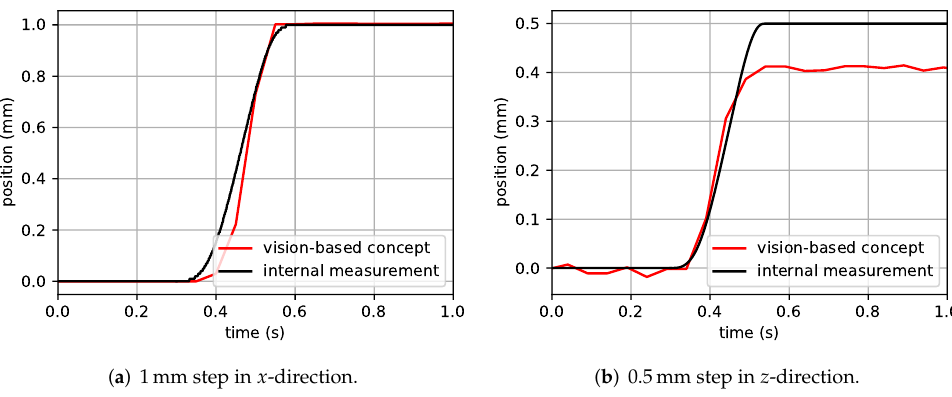
Figure 19. Measured positions for a dynamic motion of the hexapod ( a ) in x -direction and ( b ) in z -direction obtained with the proposed vision-based pose measurement system (in red) and the internal measurement system (in